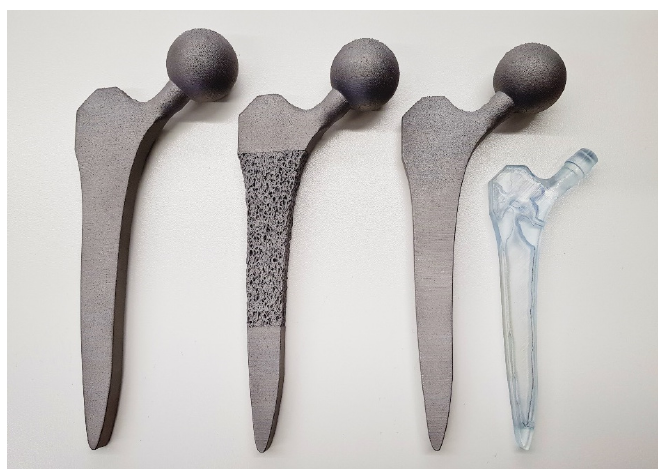
Figure 5. The successfully manufactured solid (left), porous (middle) and selectively hollowed (right) hip implants. The solid and selectively hollowed implants look identical. Thus, a clear resin plastic version of the selectively hollowed implant is also shown to indicate the internal structure of the selectively hollowed implant (right).